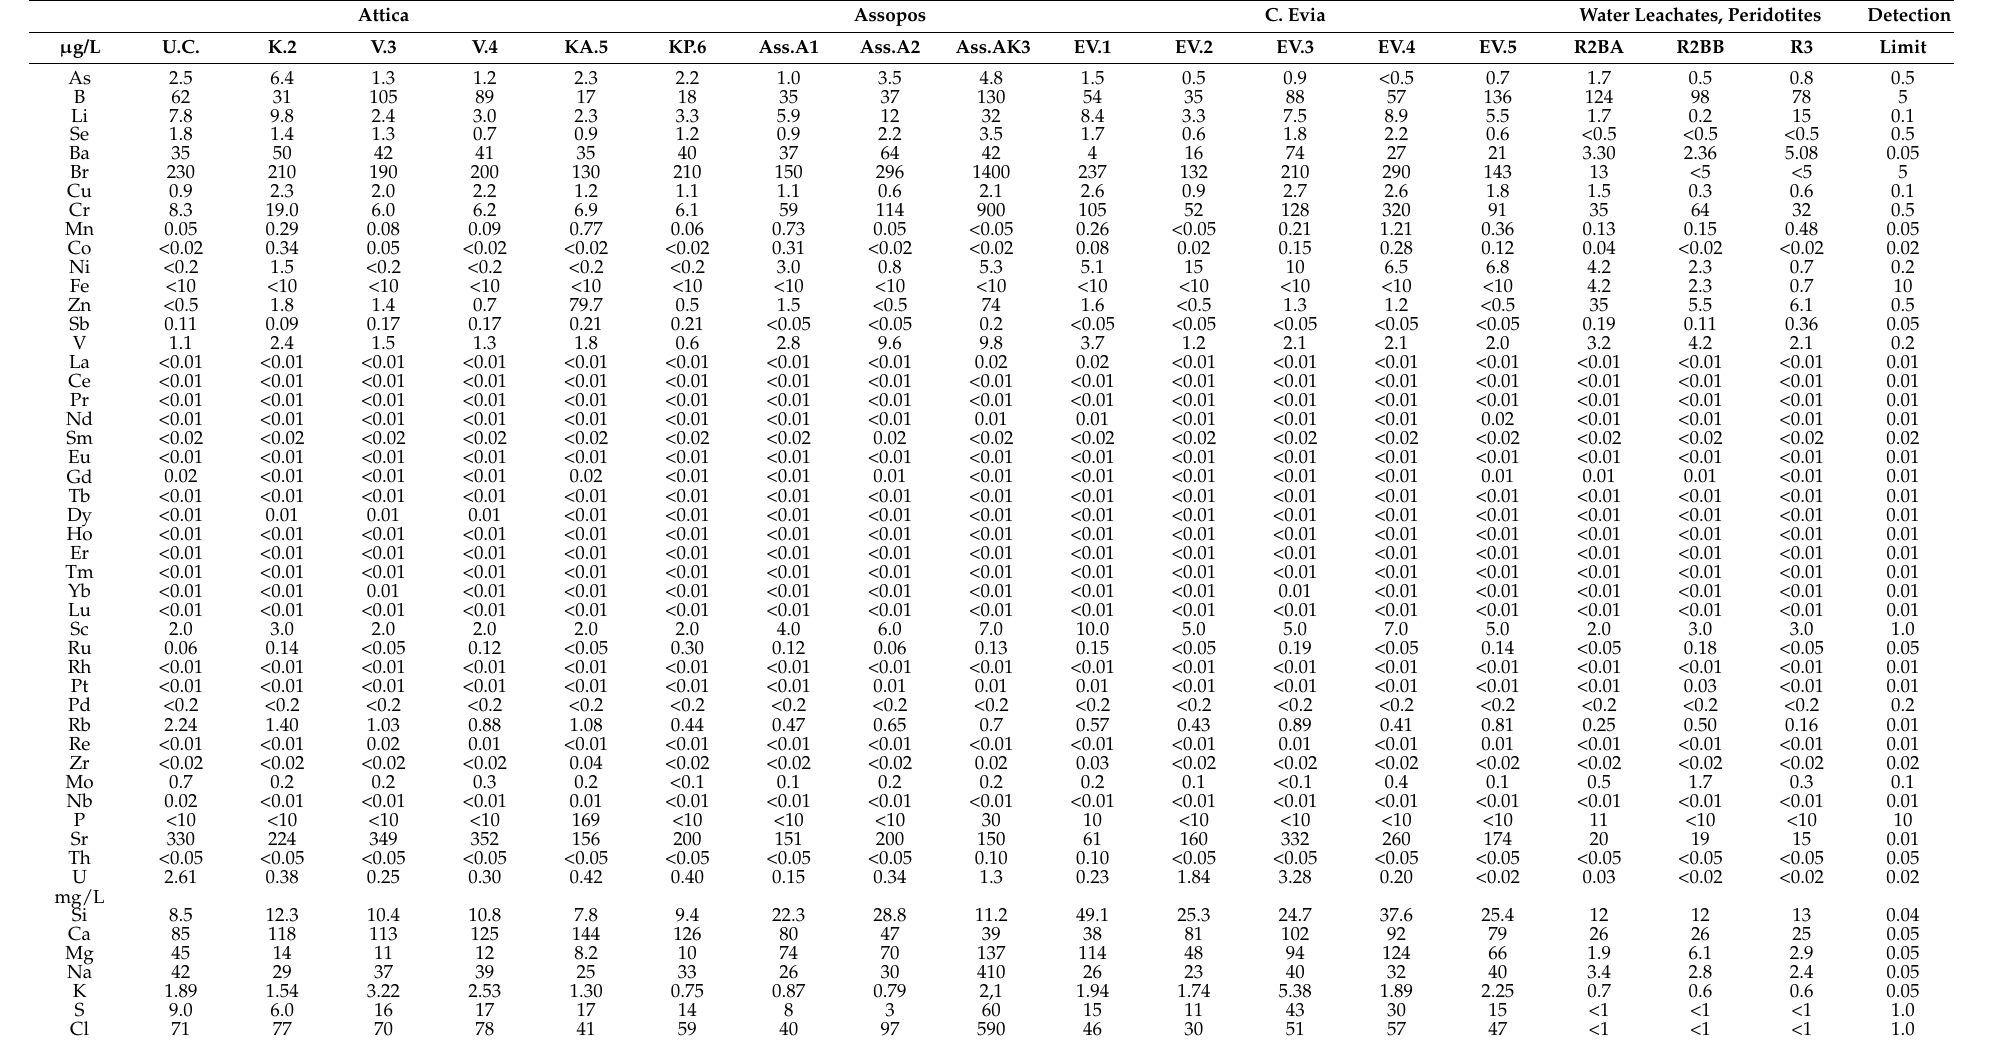
Table 1. Major and trace element concentrations in groundwater and water leachates for peridotites from C. Evia, Assopos–Thiva, and Attica